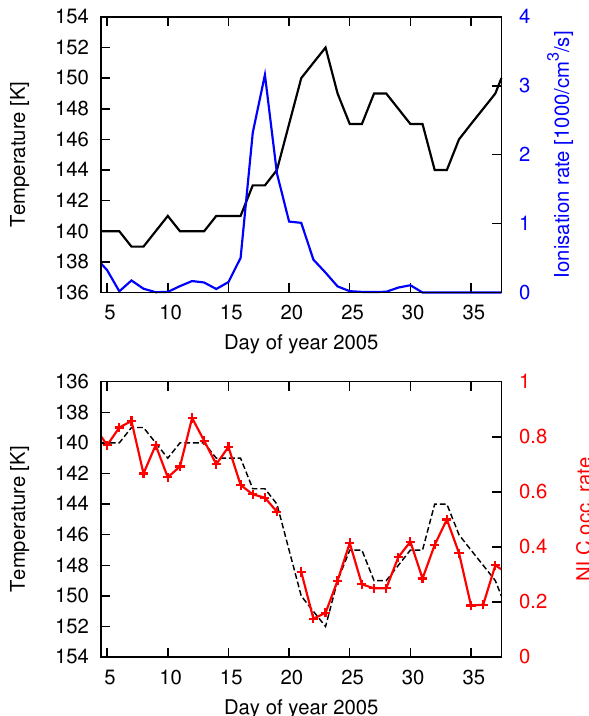
Fig. 4. Upper panel: (black solid line) zonally averaged (70–80 ◦ S) daily mean MLS temperature averaged between 80–90km, and (blue line) zonally averaged (72–82 ◦ S) daily mean ionisation rate averaged between 80–90km. Lower panel: (red line with crosses) daily mean NLC occurrence rate from SCIAMACHY measure- ments (70–80 ◦ S), and (dashed black line) MLS temperature with reversed axis orientation.